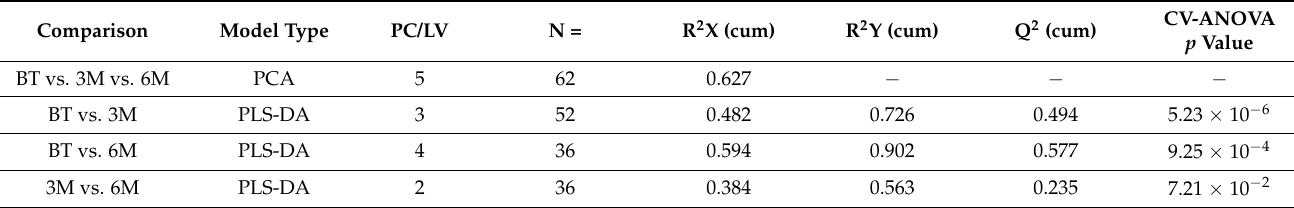
Figure 2. Boxplots for metabolites with VIP scores above 1.00 and statistical importance after p value adjustment ( q < 0.05). Red bars—RA patients before treatment; blue bars—3 months after initialization of anti-TNF treatment; green bars—6 months after treatment with TNFi. Whiskers—1.5 × interquartile range (IQR); bar—average; box—range between first quartile (Q1) and third quartile (Q3). Green line—average positive response for treatment; yellow line—average neutral response for treatment. Pink circle—data point for before treatment; red circle—data point for no information about response; green circle—data point for positive response for treatment; yellow circle—neutral response for treatment. * q value < 0.05 (precise values in Table S2). Table 1. The multivariate analysis model summary for RA patient treatment